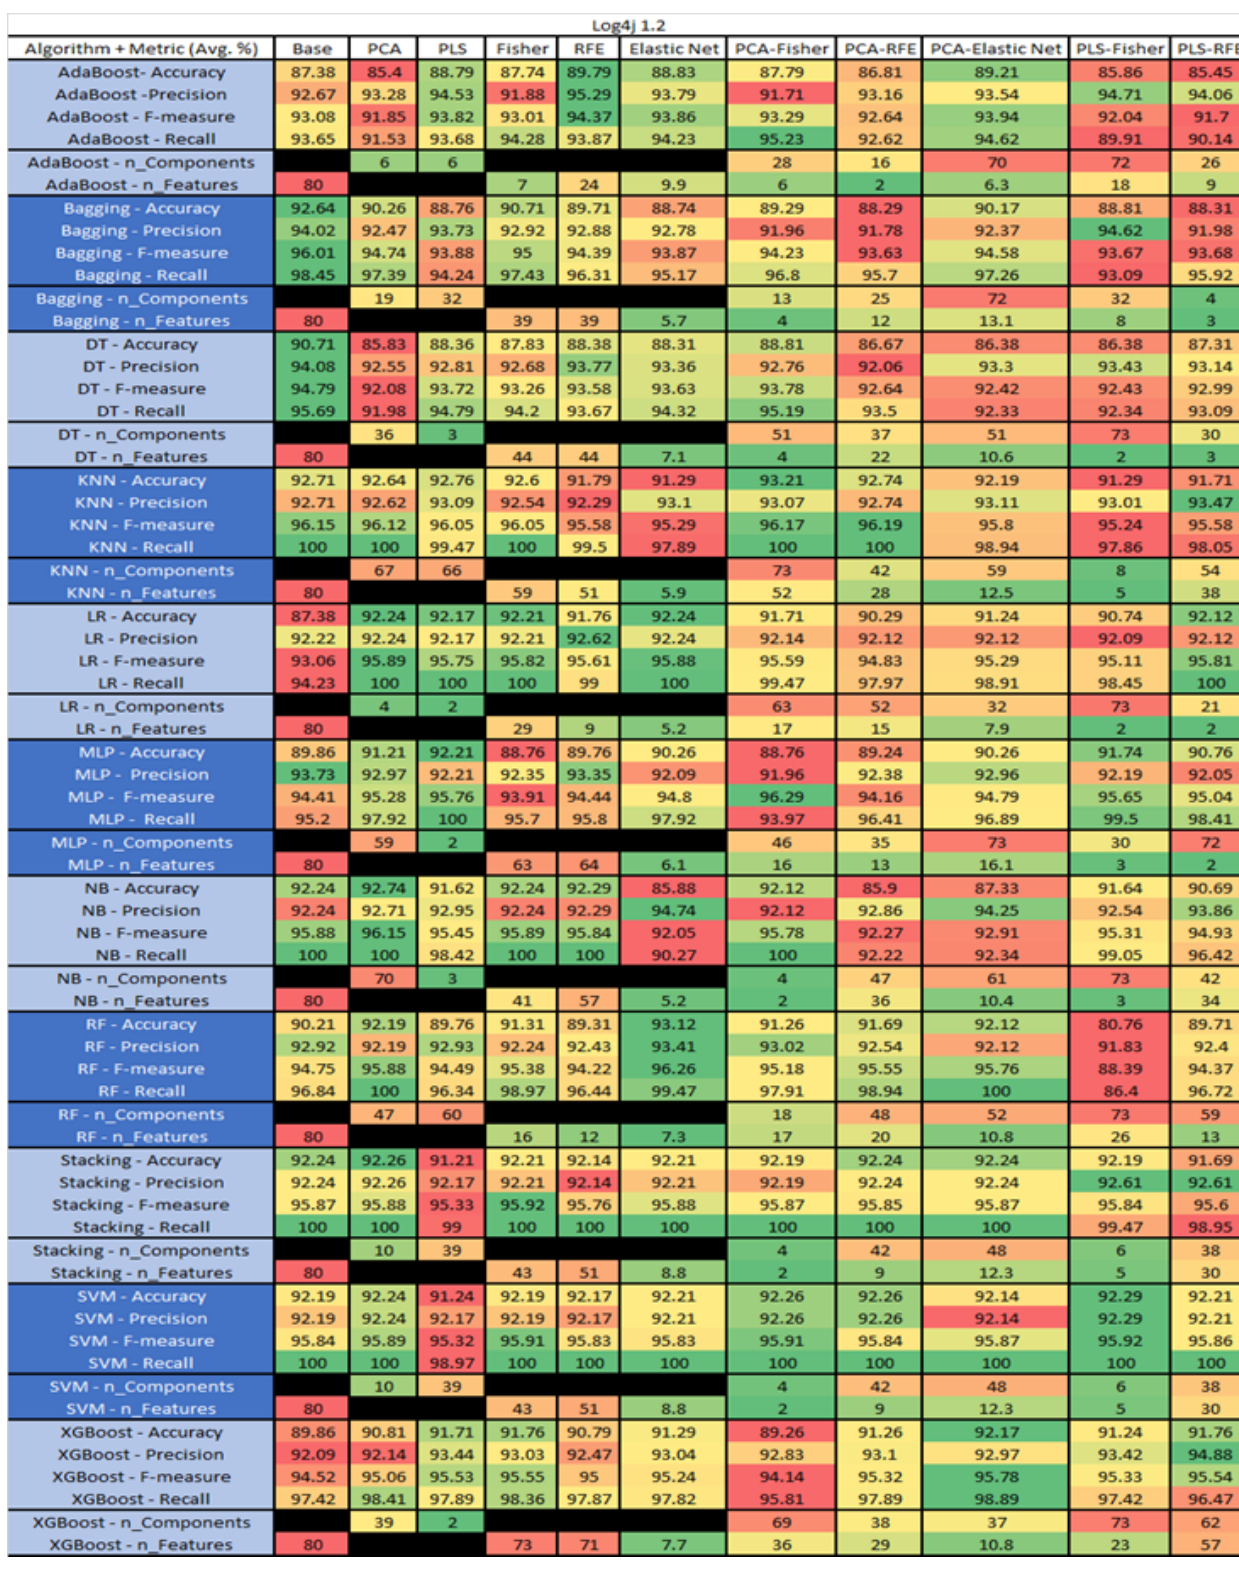
Figure 30. Log4j 1.2 PROMISE Results Data